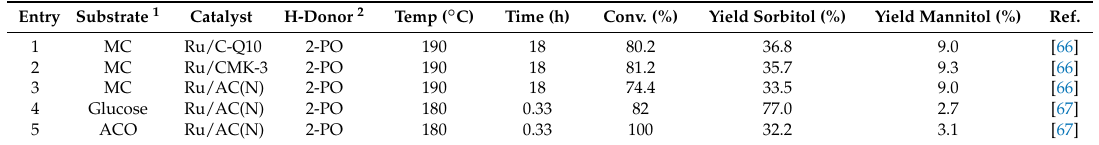
Table 3. Catalytic transfer hydrogenolysis of cellulose performed in batch conditions.